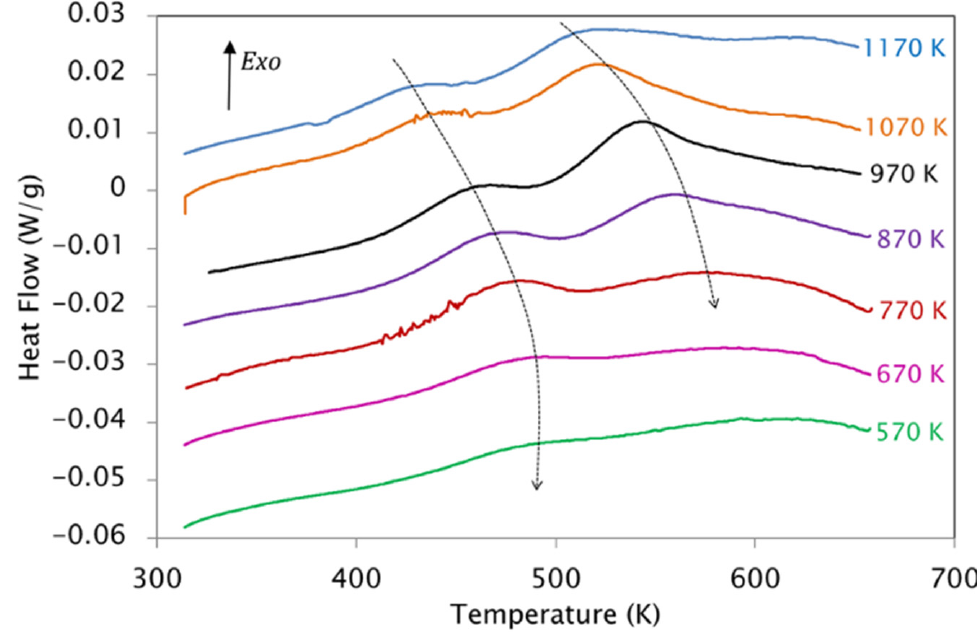
Figure 4. DSC curves obtained during heating up to 670 K Cu 5 samples previously quenched from the indicated T WQ temperatures.